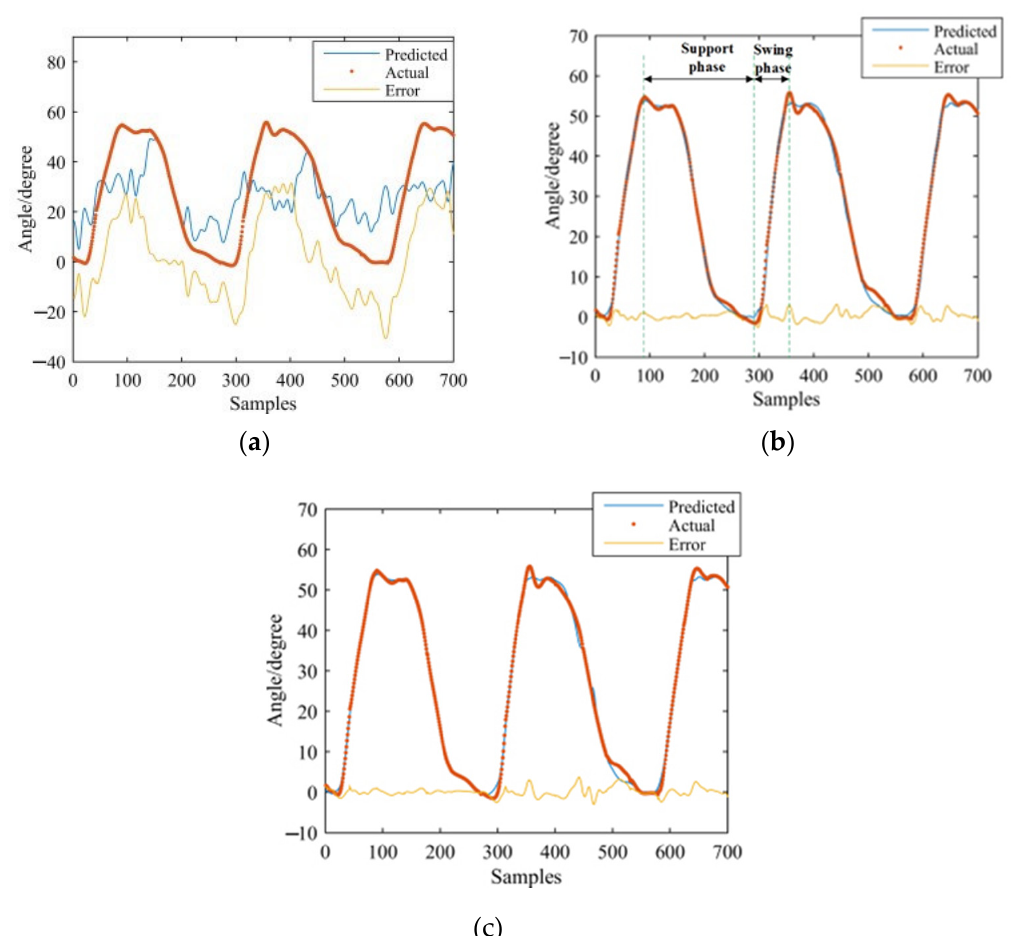
Figure 13. Prediction results of hip-joint angle in the going upstairs process. ( a ) Results of IN1; ( b ) Results of IN2; ( c ) Results of IN3.